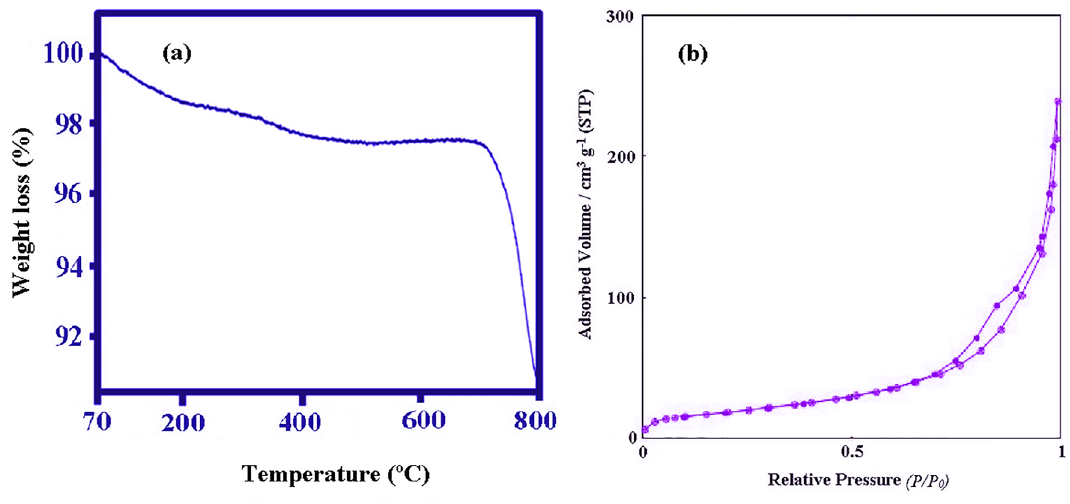
Figure 11. ( a ) TGA and ( b ) Nitrogen adsorption–desorption isotherm of Fe 3 O 4 @SiO 2 -PMA-Cu.